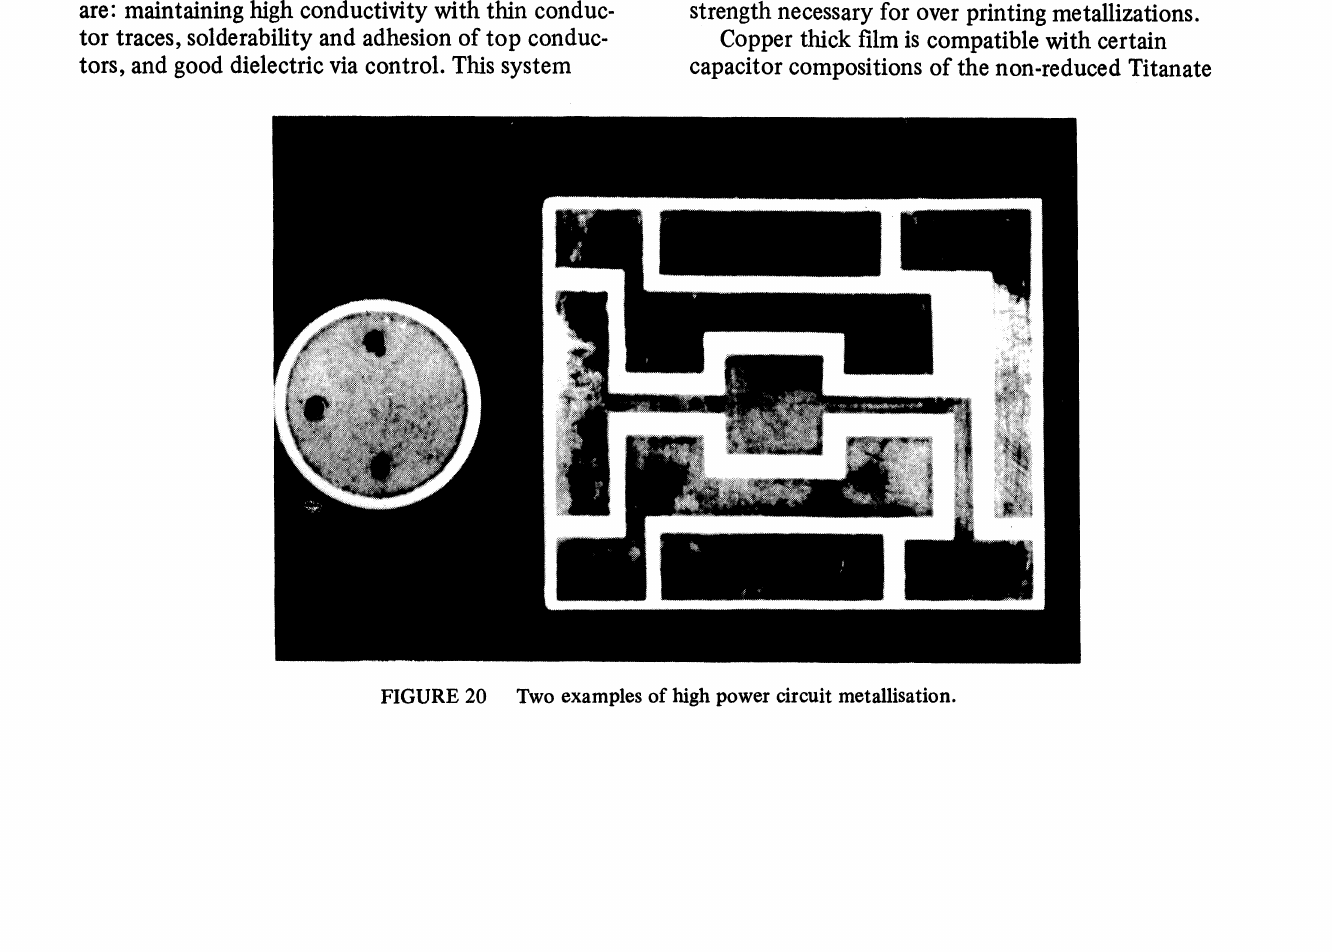
FIGURE 19 Copper metallised circuit which provides for flip chip reflow solder attachment of 4 bump integrated circuit chips. systems. Thus, screen printing of NPS resistors directly onto the Copper microstrip circuits is feasible.